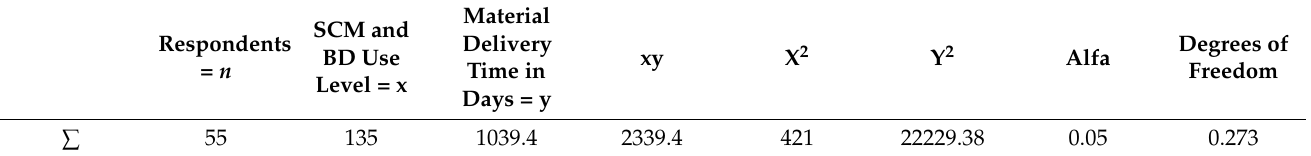
Table 3. Results of correlation analyses: Exploitation of big data concept and supply chain management shortens delivery time of materials and services in sustainable building project.